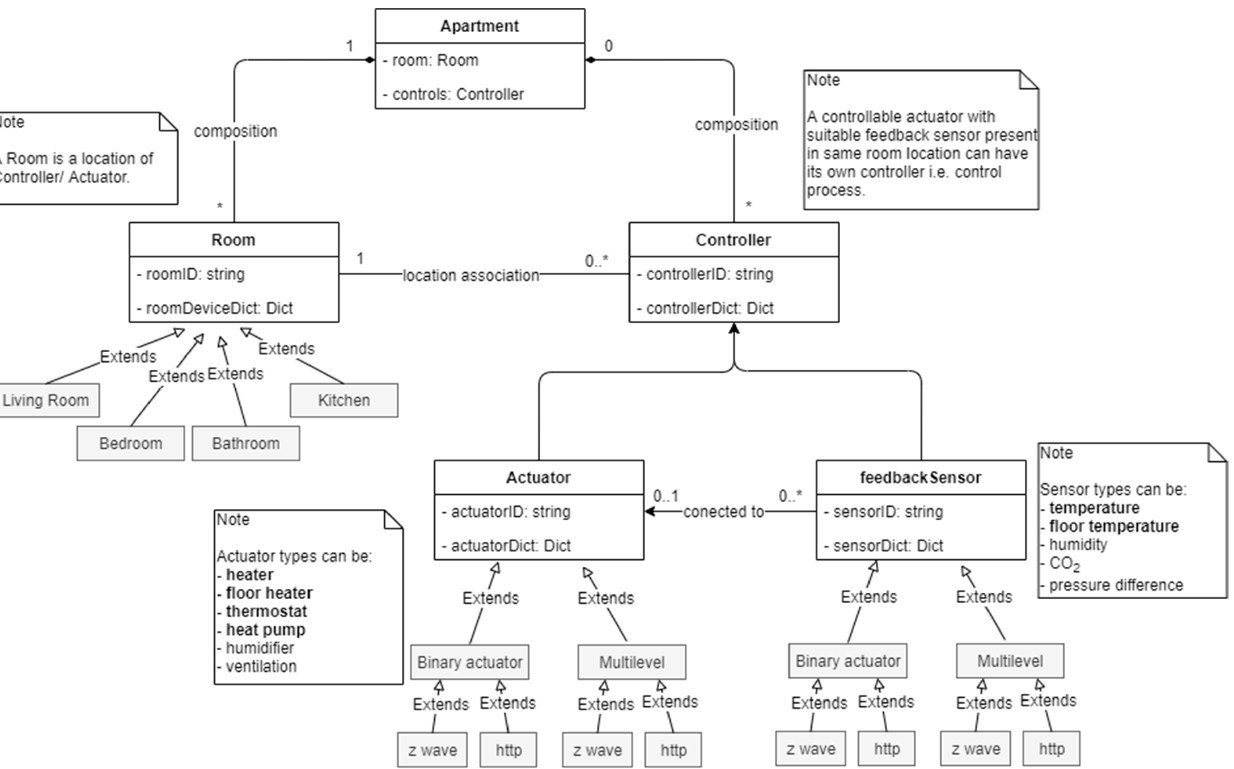
Figure 5. This is a class diagram of automatic aggregation software.